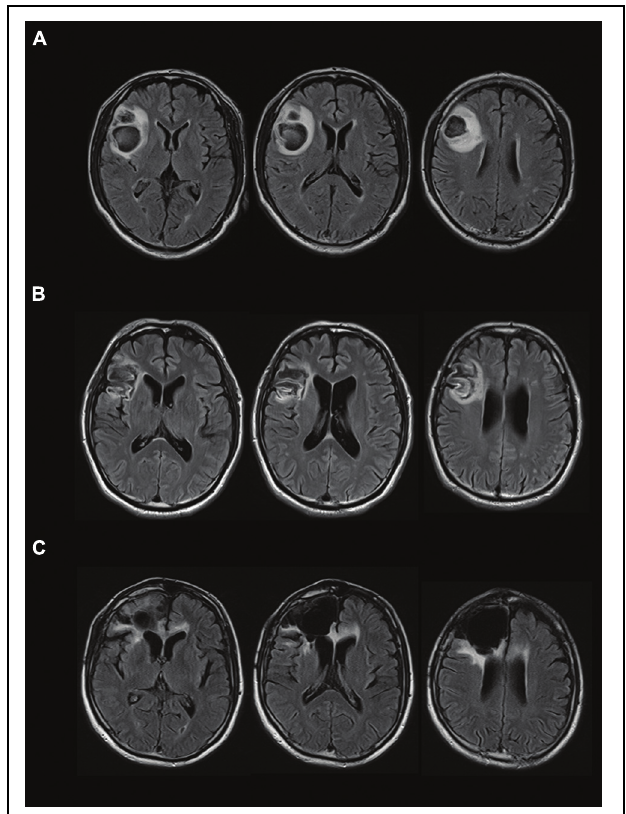
FIGURE 1 | Transverse magnetic resonance imaging with FLAIR acquisition of the brains of the cases. Left sides of images correspond to the right side of the brain. (A) Case A, (B) Case B, and (C) Case